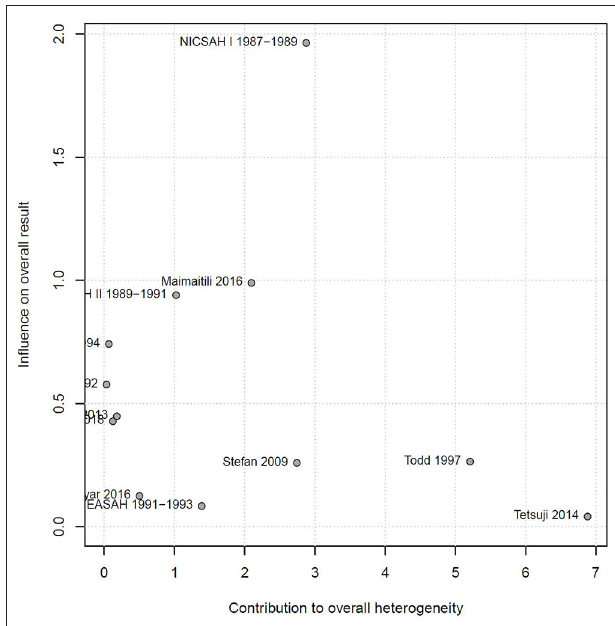
FIGURE 3 | Baujat graph shows the source of heterogeneity.